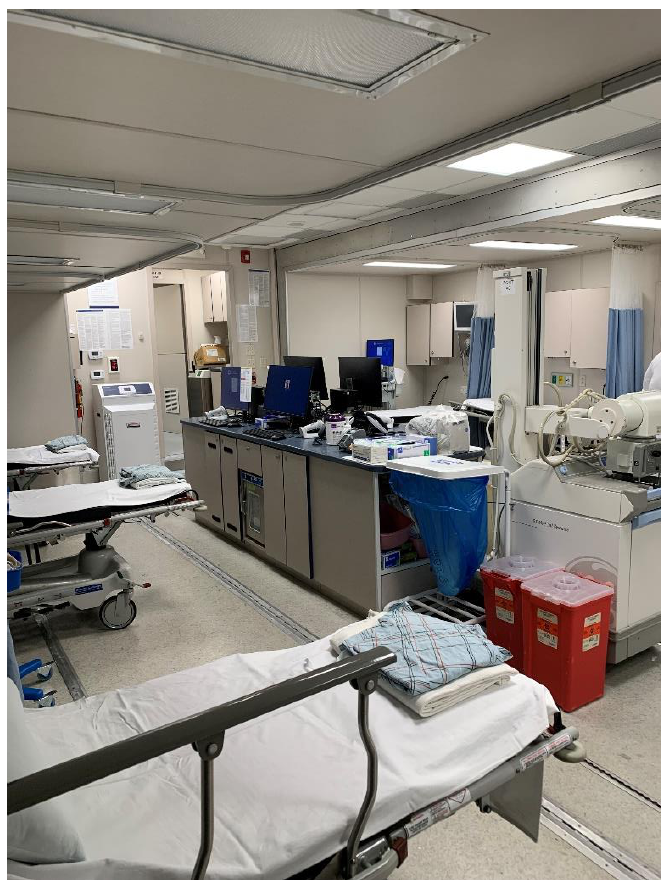
Figure 2. Internal view MSED set up for COVID treatment.